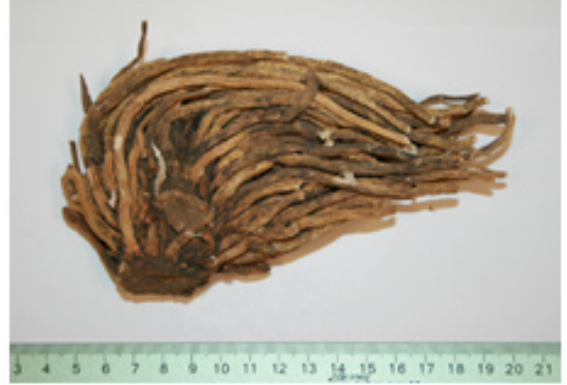
Figure 1: Veratrum lobelianum rhizomes (Photo credit to